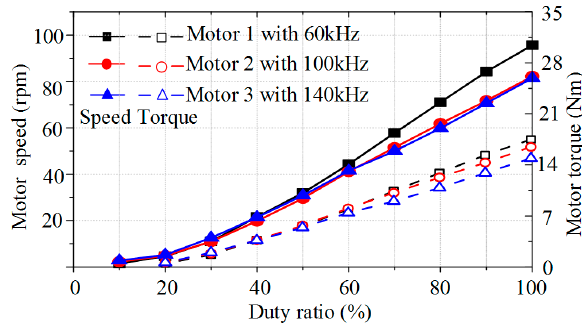
Figure 8. Motor speed regulation by burst fire control.